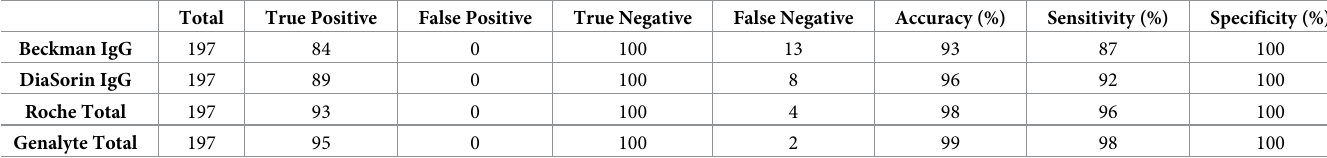
Table 2. Performance of COVID-19 serology assays.